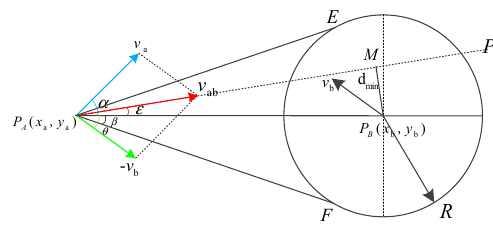
Figure 3. Velocity obstacle model.